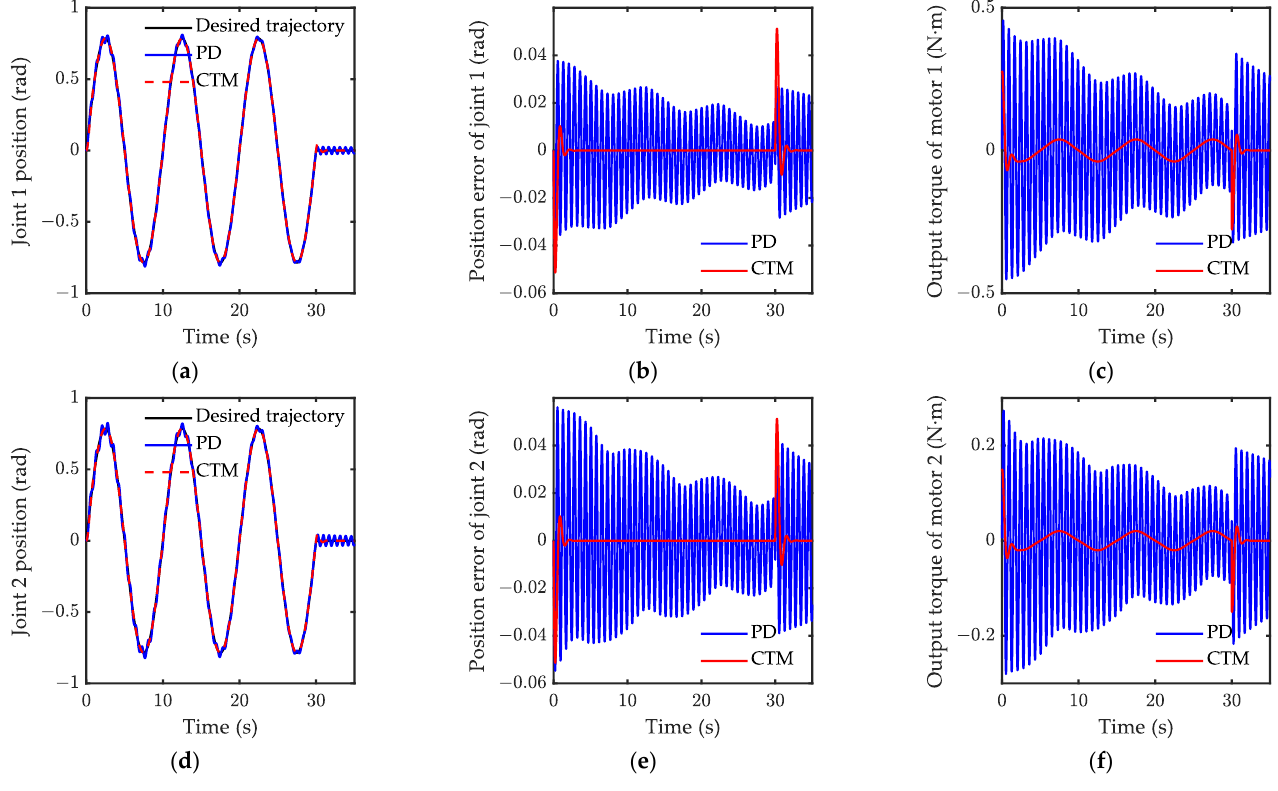
Figure 16. Simulation result of motion for case 2: ( a ) joint 1 position; ( b ) position error of joint 1; ( c ) output torque of motor 1; ( d ) joint 2 position; ( e ) position error of joint 2; ( f ) output torque of motor 2.